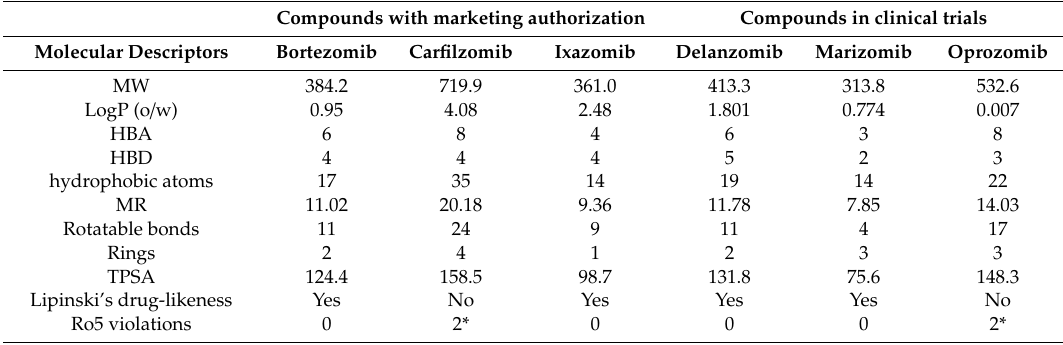
Table 3. Molecular descriptors for proteasome inhibitors already with marketing authorization or in clinical trials.